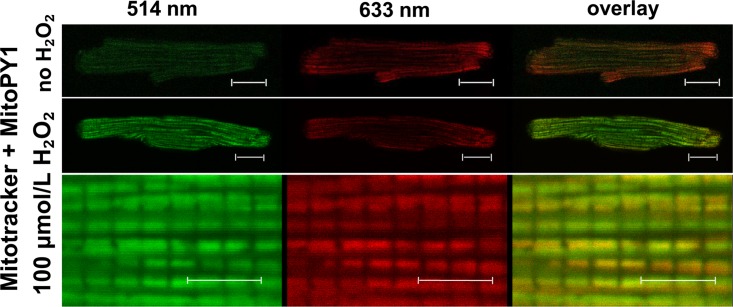
Measurement of mitochondrial H2O2 in cardiomyocytes using MitoPY1.Confocal imaging of cardiomyoytes loaded with MitoTracker Deep Red and MitoPY1 before and after H₂O₂-challenge. H₂O₂ (100 μmol/L) was added directly to the coverslips and incubated for 10 min before re-imaging again. Scale bars: 20 μm, top panels and 5 μm, bottom panels. As expected, the MitoPY1 signal was low in the basal state but increased substantially upon addition of H2O2. The high resolution image (bottom panel) reveals individual interfibrillar mitochondria and the overlay of green MitoPY1 signal and red Mitotracker signal (right panels) confirms the dye’s mitochondrial localisation.